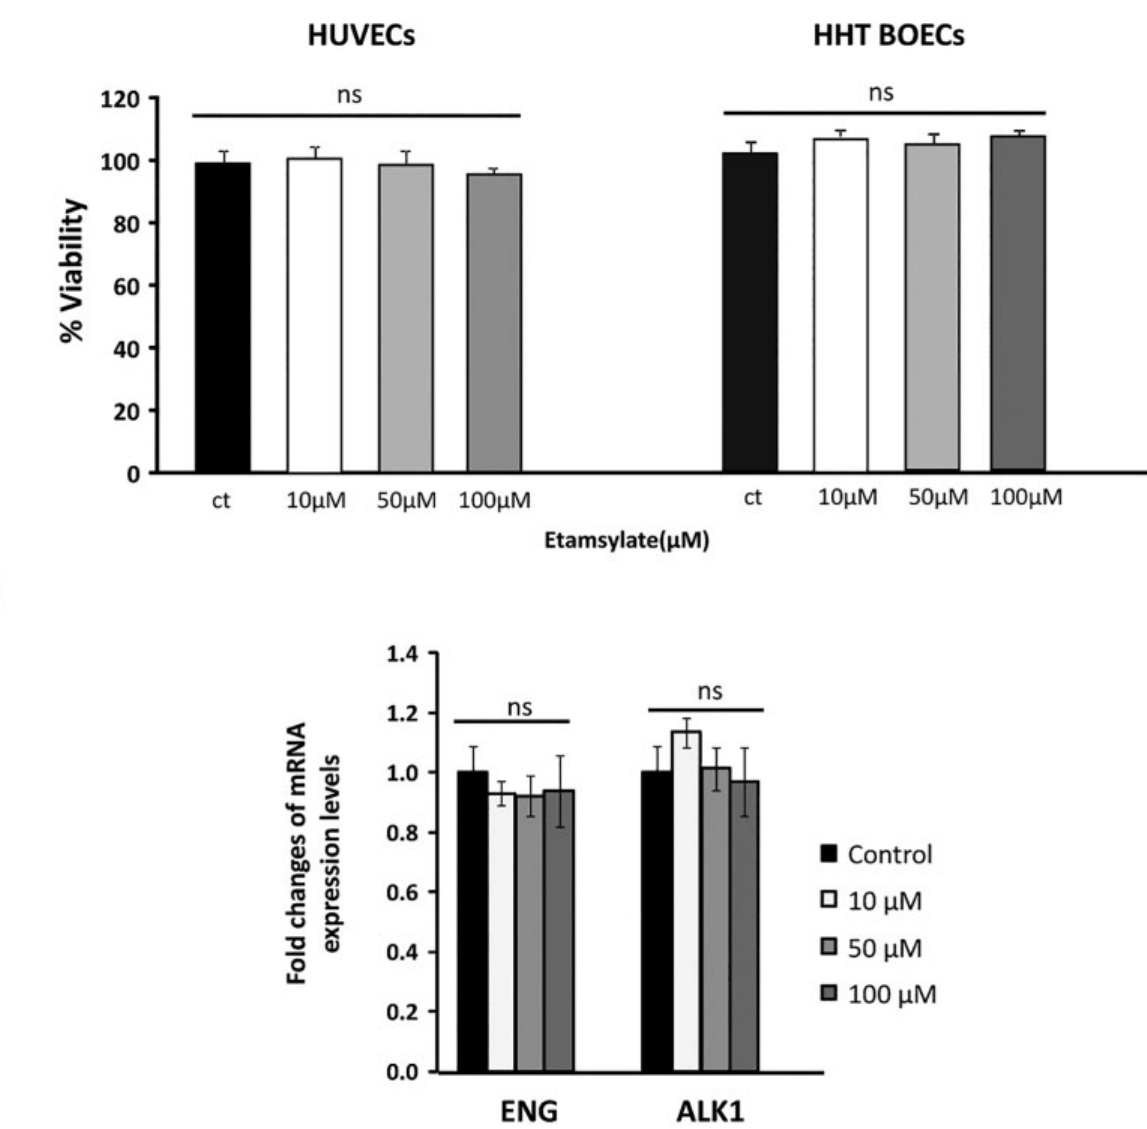
Fig. 5 Effect of etamsylate on viability and Endoglin and ALK1 RNA expression. ( A ) Viability of HUVECs and BOECs cells in the 0 to 100 μ M range of etamsylate treatment is not affected. ( B ) RNA expression of ENG and ALK1 after treatment with different doses of etamsylate in HUVECs. RNA levels of ACVRL1/ALK1 and Endoglin were determined by RT-qPCR in HUVECs, after etamsylate treatments (range: 10 – 100 μ M), and normalized with the untreated controls. Statistical signi fi cance was studied using Student ’ s t -test. No signi fi cant difference was found. BOECs, blood outgrowth endothelial cells; HUVECs, human umbilical vein endothelial